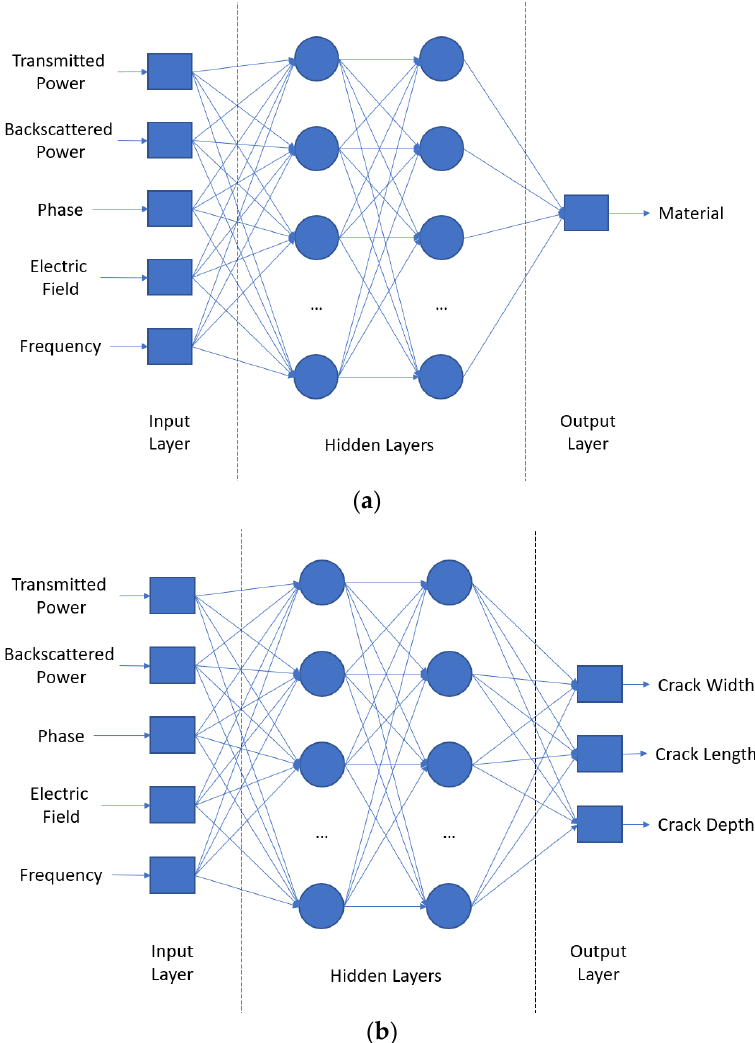
Figure 2. MLNN structure for RFID-based sensing: ( a ) material identification MLNN and ( b ) crack sensing MLNN.